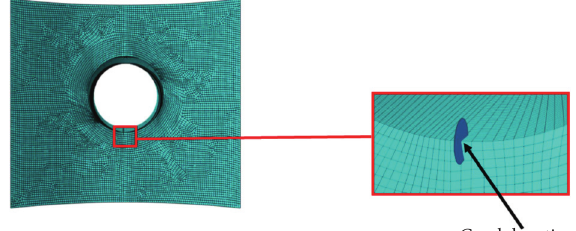
Figure 7: RPV submodel with postulated axial semielliptical surface crack created in the Abaqus